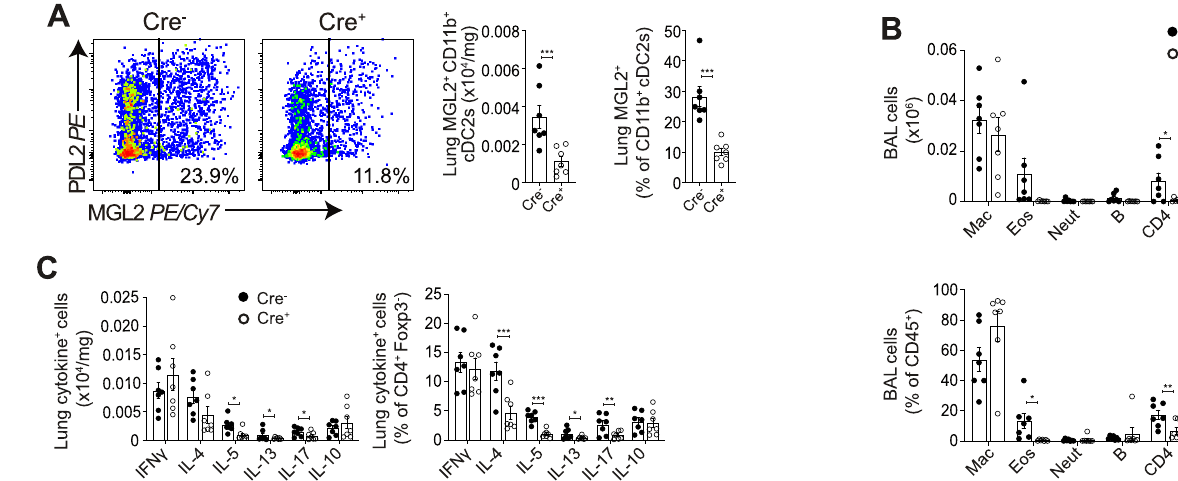
Fig. 7 | Pulmonary IRF4 -dependent cDC2s are required to promote pulmonary type-2 immune responses in patent murine schistosome infection. CD11c Δ Irf4 mice were percutaneously infected with 180 cercariae, and pulmonary samples takenatd49. A Representative fl owcytometryplotsshowdepletionofMGL2 + IRF4 dependent cDC2s. Gate frequencies show % of CD11b + cDC2s. B BAL cell isolates were assessed via fl ow cytometry for macrophages, eosinophils, neutrophils, B cells, CD4 + and CD8 + T cells. C Lung cell isolates were stimulated with PMA/